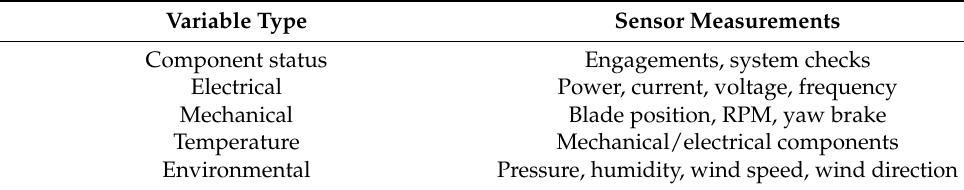
Table 1. Internal categorization of WTS